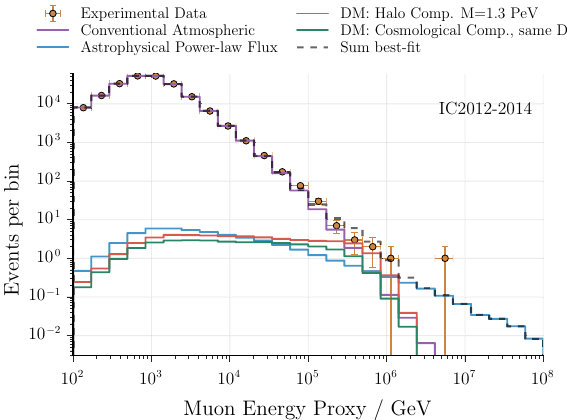
Fig. 4 Track analysis: best-fit energy distribution. While the low- energy events are well described by the conventional atmospheric com- ponent,thehigh-energyeventsaremodelledbyacombinationofaweak diffuse astrophysical flux and a component from decaying dark matter (best-fitparametersinTable2).Thefigureshowsdatarecordedbetween 2012 and 2014 as they are based on the same energy estimator (see [67] for more details). The remaining years are fitted simultaneously but are not shown here